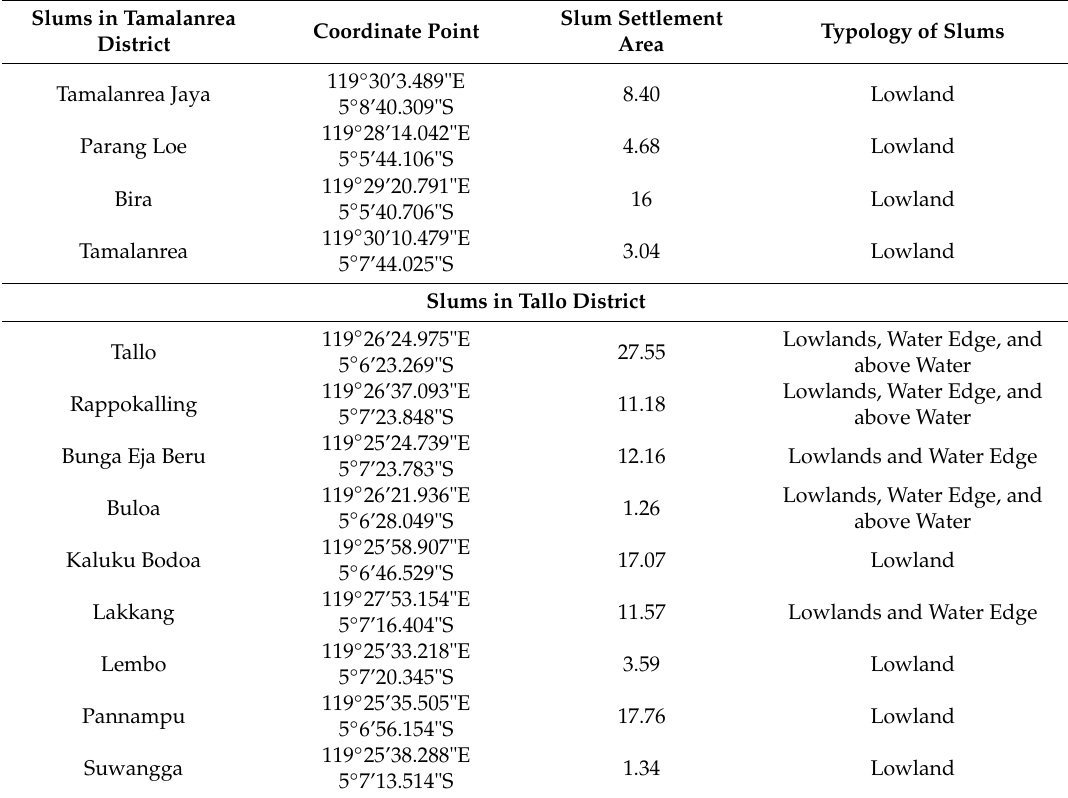
Table 1. Geographical Location and Typology of Slums Based on Kelurahan in Tamalanrea District and Tallo District in Makassar City.